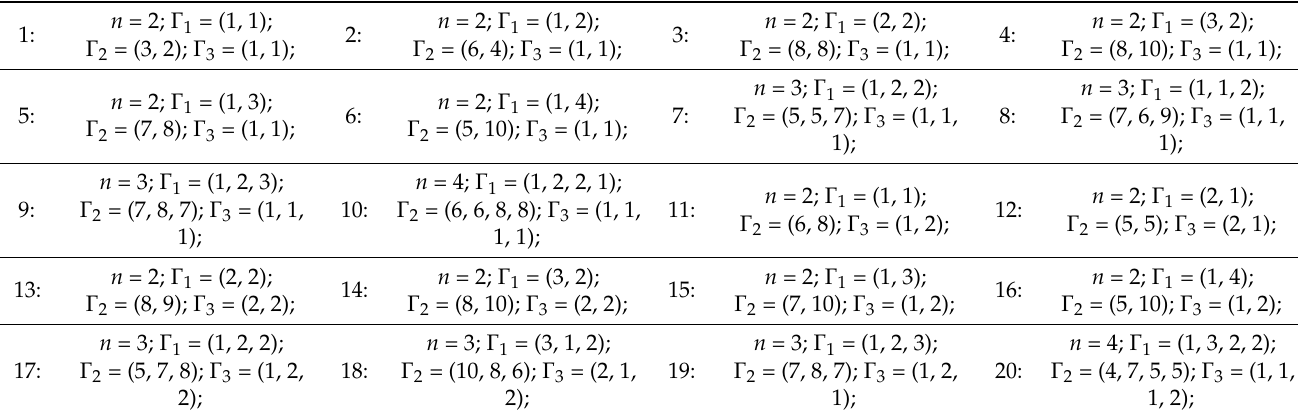
Table 1. The 20 cases used for